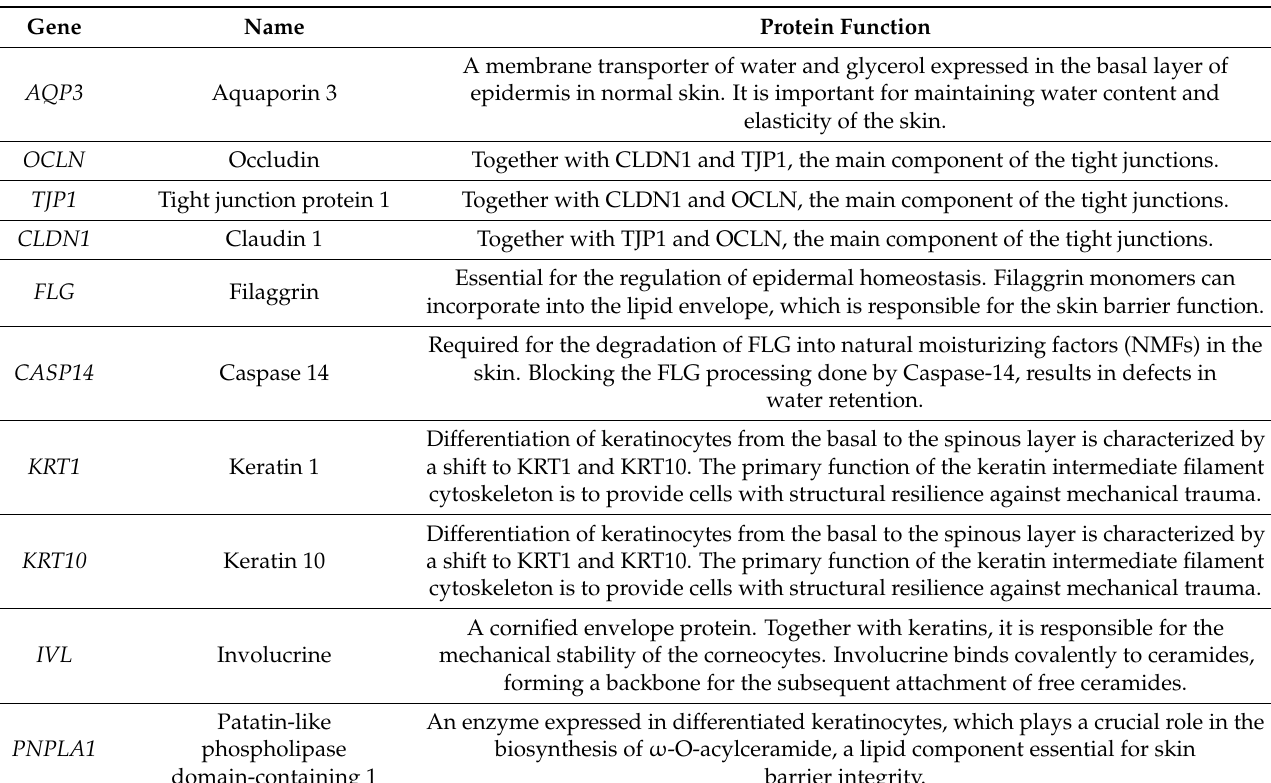
Table 2. List of genes screened by quantitative